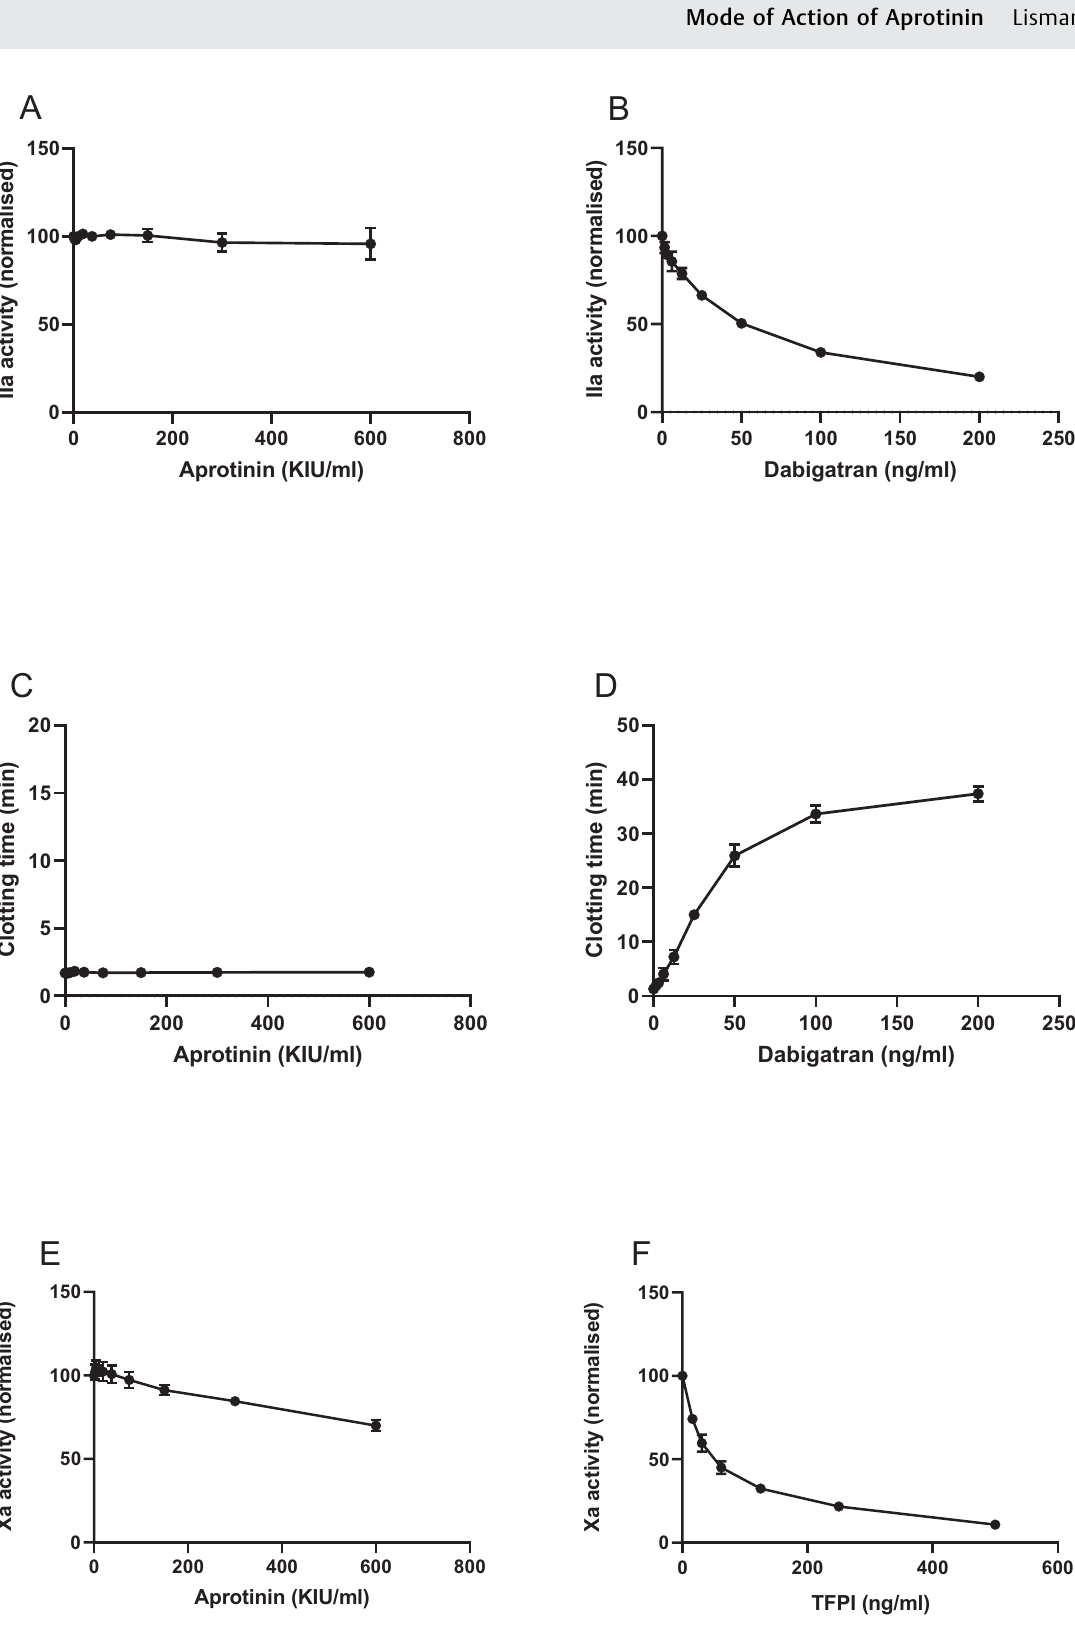
TH Open Vol. 5 No. 3/2021 © 2021. The